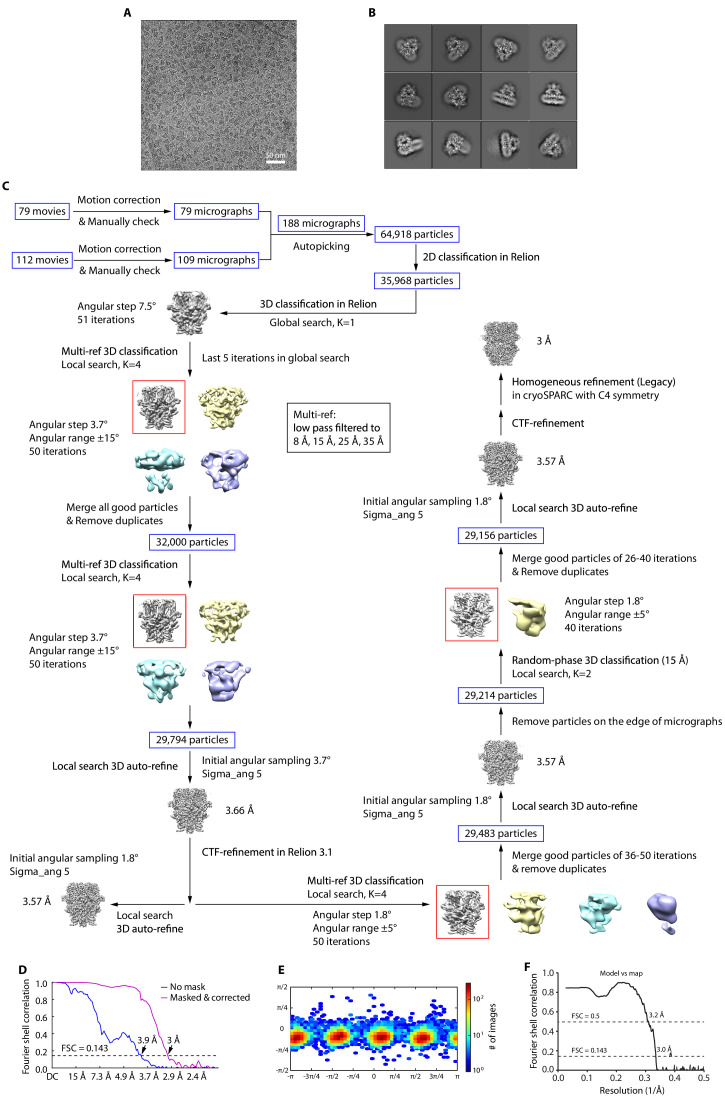
Cryo-EM image analysis of apo human TRPC5 (hTRPC5).(A) Representative raw micrograph recorded on K2 Summit camera. (B) Representative 2D class averages of apo hTRPC5. (C) Flowchart for cryo-EM data processing of apo hTRPC5. (D) Fourier shell correlation (FSC) curves of the two independently refined maps for unmasked (blue line, 3.9 Å) and corrected (purple line, 3 Å). Resolution estimation was based on the criterion of FSC 0.143 cut-off. (E) Angular distribution of clemizole (CMZ)-bound hTRPC5. This is a standard output from cryoSPARC. (F) FSC curve of the refined model versus EM map.